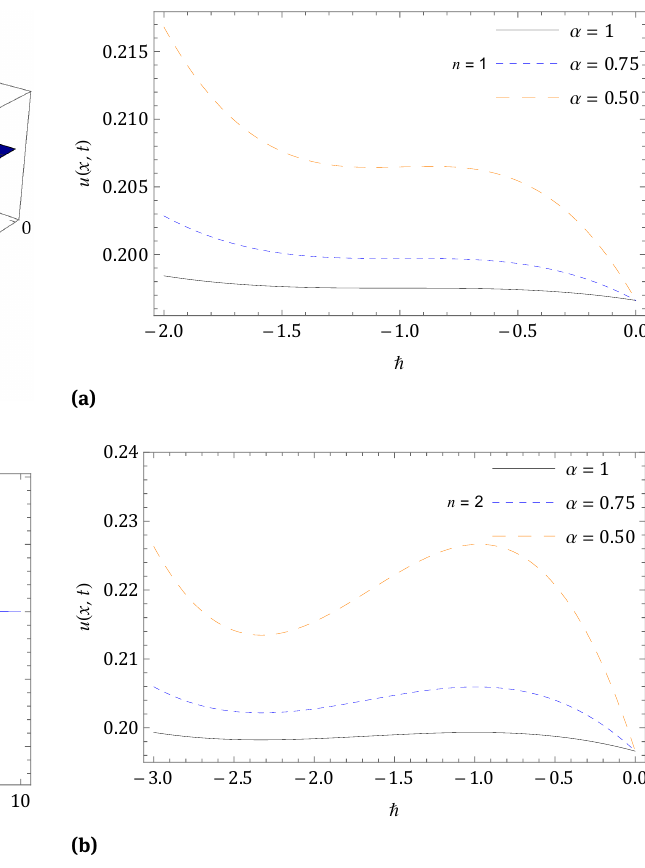
Figure 3: (a) Surface of u ( x , t ) , ( b ) 2D plot of u ( x , t ) at t = 10 at µ = 0.5, (cid:125) = −1, n = 1 and α = 1 .